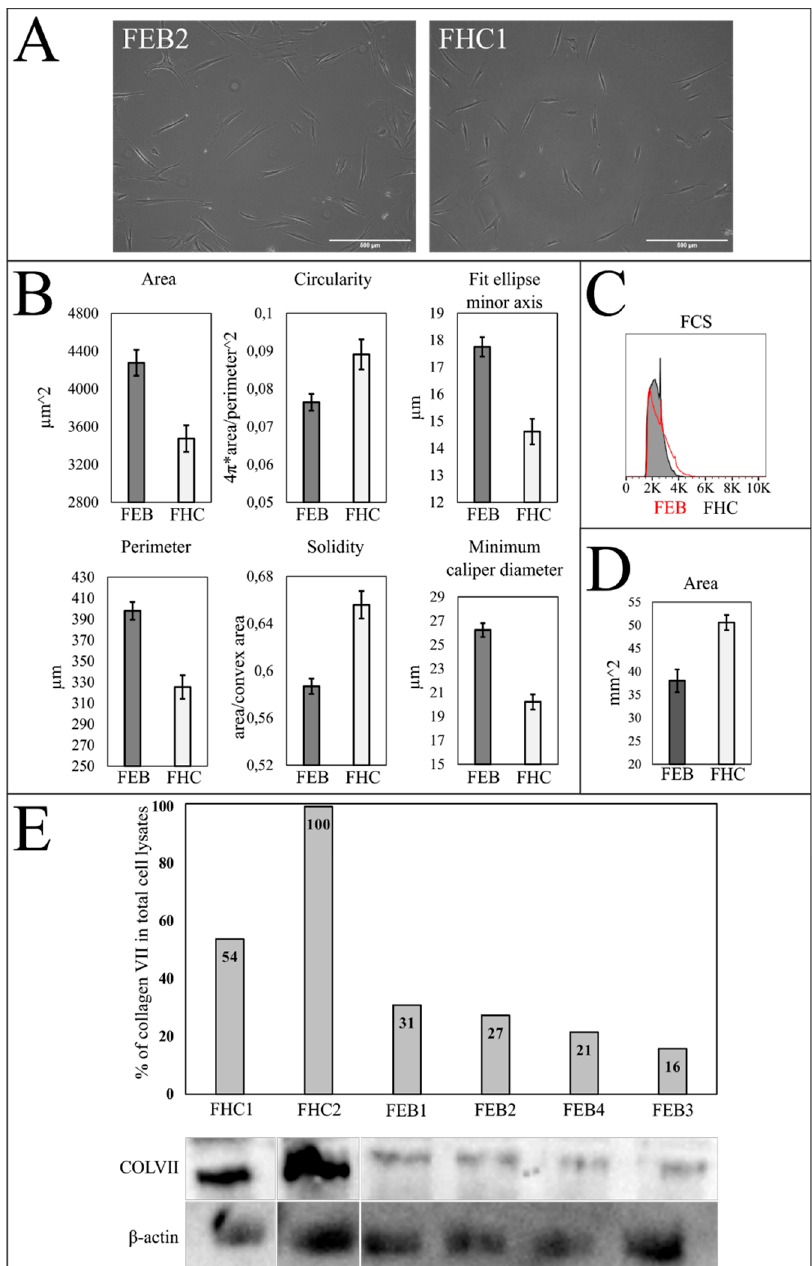
Figure 4. FEB and FHC comparison. ( A ) Phase-contrast microscopy of fibroblasts in culture. Magnification × 100. ( B ) The results of morphological analysis of FEB and FHC. Area, perimeter, minimum caliper diameter and fit ellipse minor axis are significantly bigger ( p < 0.05) and circularity and solidity are significantly lower ( p < 0.05) for FEB compared to FHC when compared by two-sample t test. Error—standard error. ( C ) Forward Scatter FSC histogram of FHC and combined FEBs (1–4). Distributions are significantly different (T(x) = 868; p < 0.05). ( D ) Collagen gel contraction assay. The results of the Mann–Whitney test show that distributions are significantly different ( p < 0.05). ( E ) Western blot analysis of total cell lysates. Semi ‐ quantitative estimation of type VII collagen expression. β‐ actin used as a loading control. SDS ‐ PAGE (8%) with 8 M urea, anti ‐ collagen VII polyclonal antibody (upper panel) and anti ‐β‐ actin (lower panel); electro ‐ chemiluminescence (ECL) detection. For the uncut and unadjusted version, see Supplementary Figure S3.